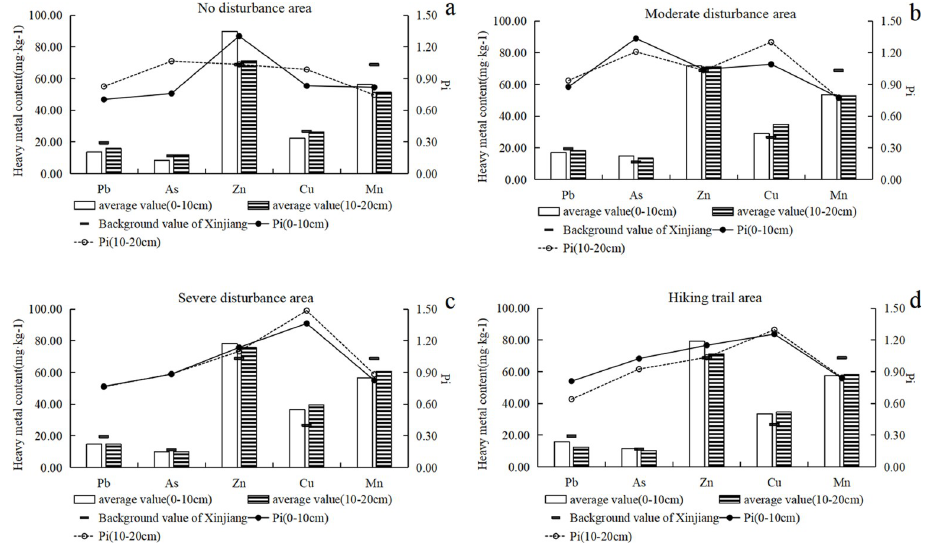
Fig 3. Heavy metal concentration in soil under different disturbance levels in Lujiaowan Scenic Area.